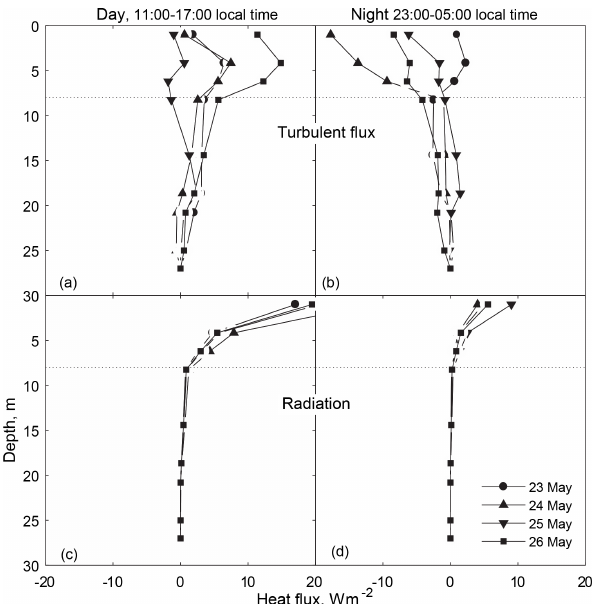
Figure 5. Vertical turbulent (a, b) and radiation (c, d) heat fluxes in the bulk of the water column. (a, c) show the daytime averages; (b, d) correspond to the nighttime